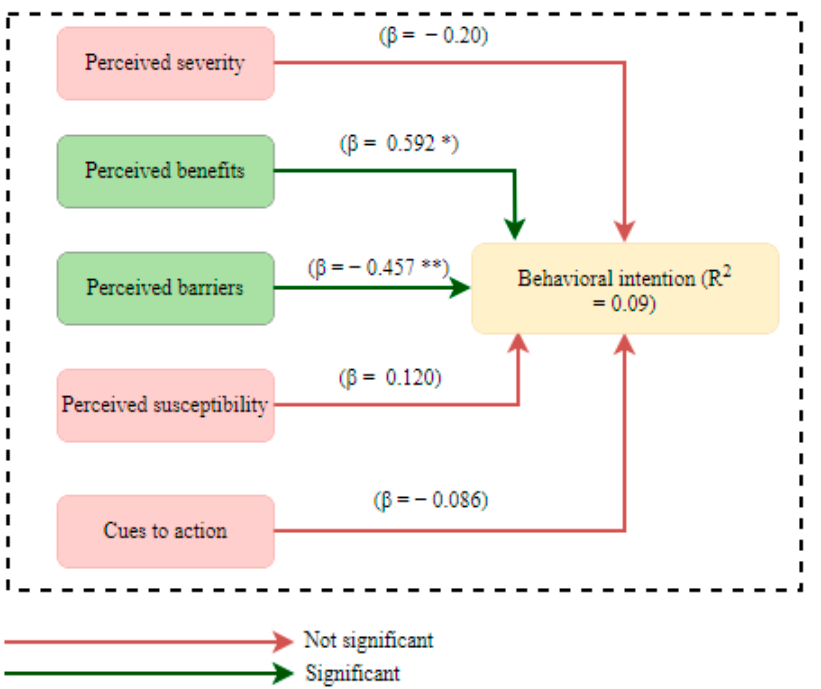
Figure 6. Predicting Behavioral intention based on the Health Belief Model constructs (Model 2). R 2 = Nagelkerke R square, * p < 0.05, ** p < 0.001.